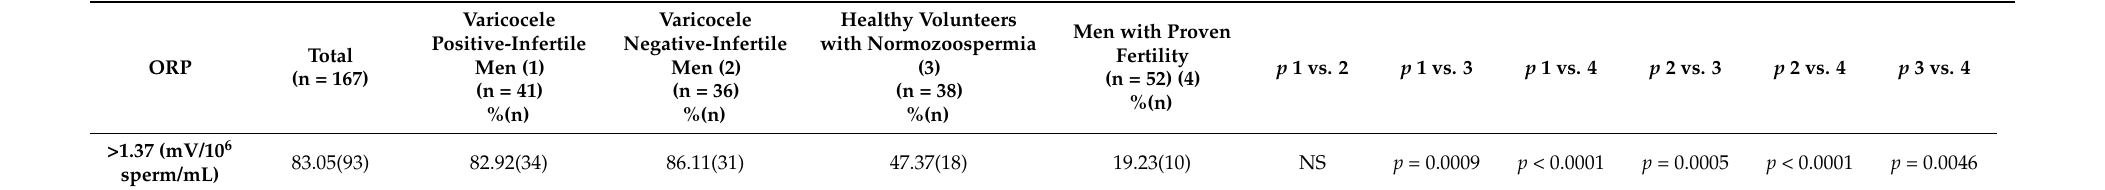
Table 4. Prevalence of high ORP in study groups.